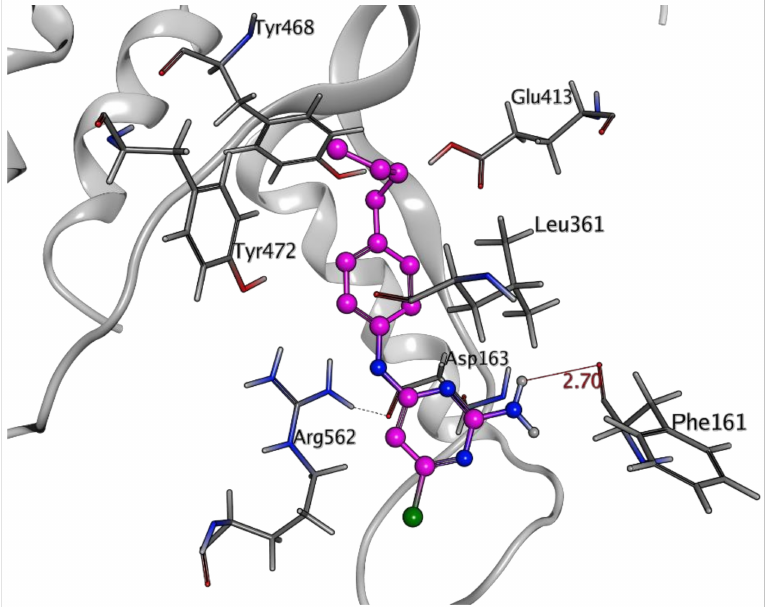
Figure 9. The three-dimensional picture of the least active compound 23 presents the similar binding and molecular interactions, as exhibited by a moderately active compound 8 , with insignificant residues in the binding pocket of β